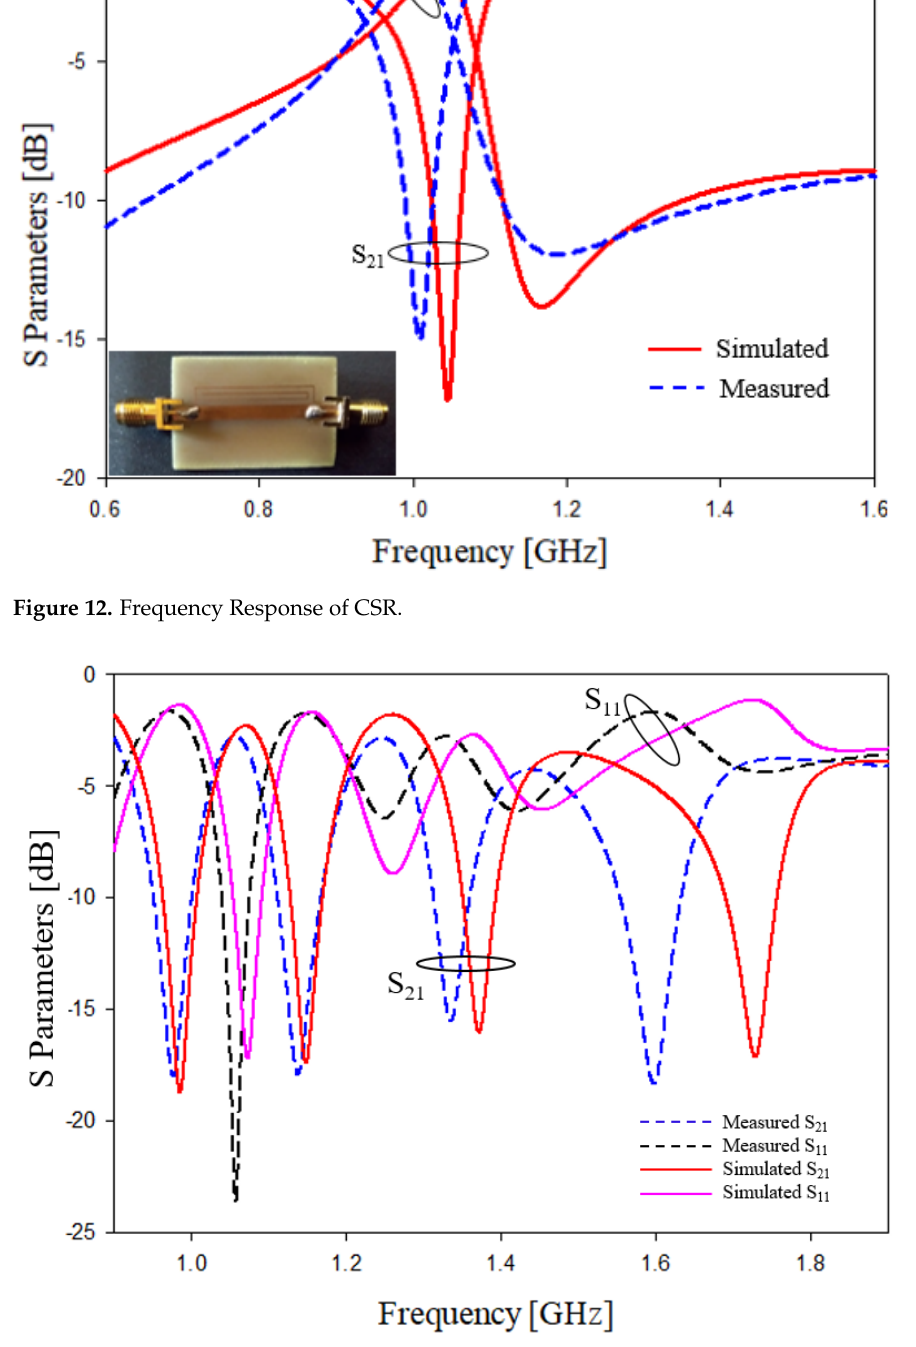
Figure 13. Frequency Response of 4 bit CSR with code